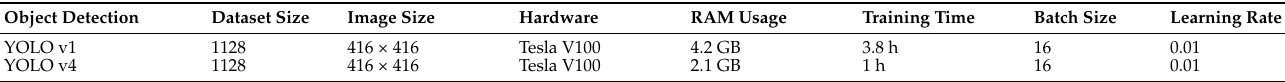
Table 5. YOLO object detection model experimental